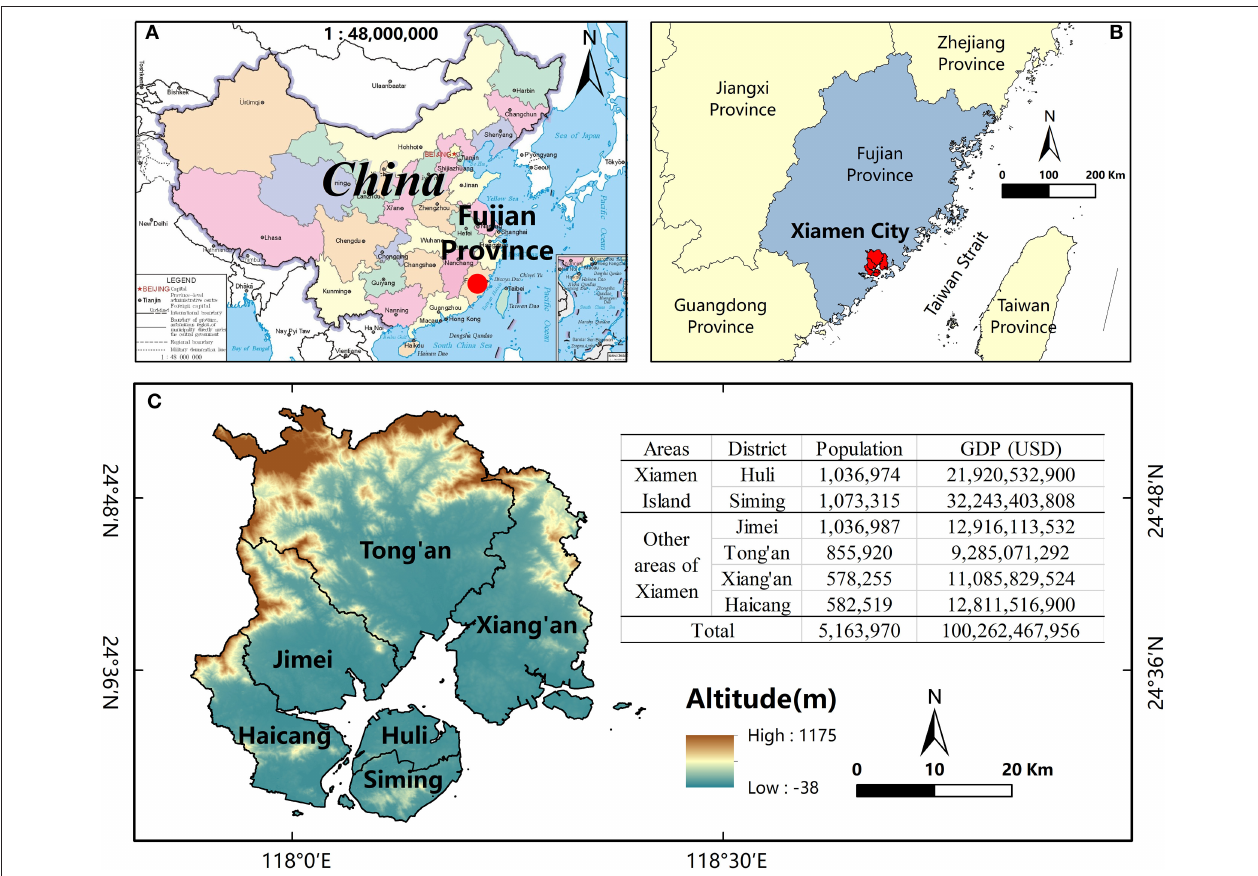
FIGURE 1 | The location of Xiamen City. (A) Fujian Province in China; (B) Xiamen City in Fujian Province; (C) the six districts and elevation map of Xiamen City. Background map source: National Geomatics Center of China. Population data source: the 7th National Census (2020). GDP data source: 2021 Yearbook of Xiamen Special Economic